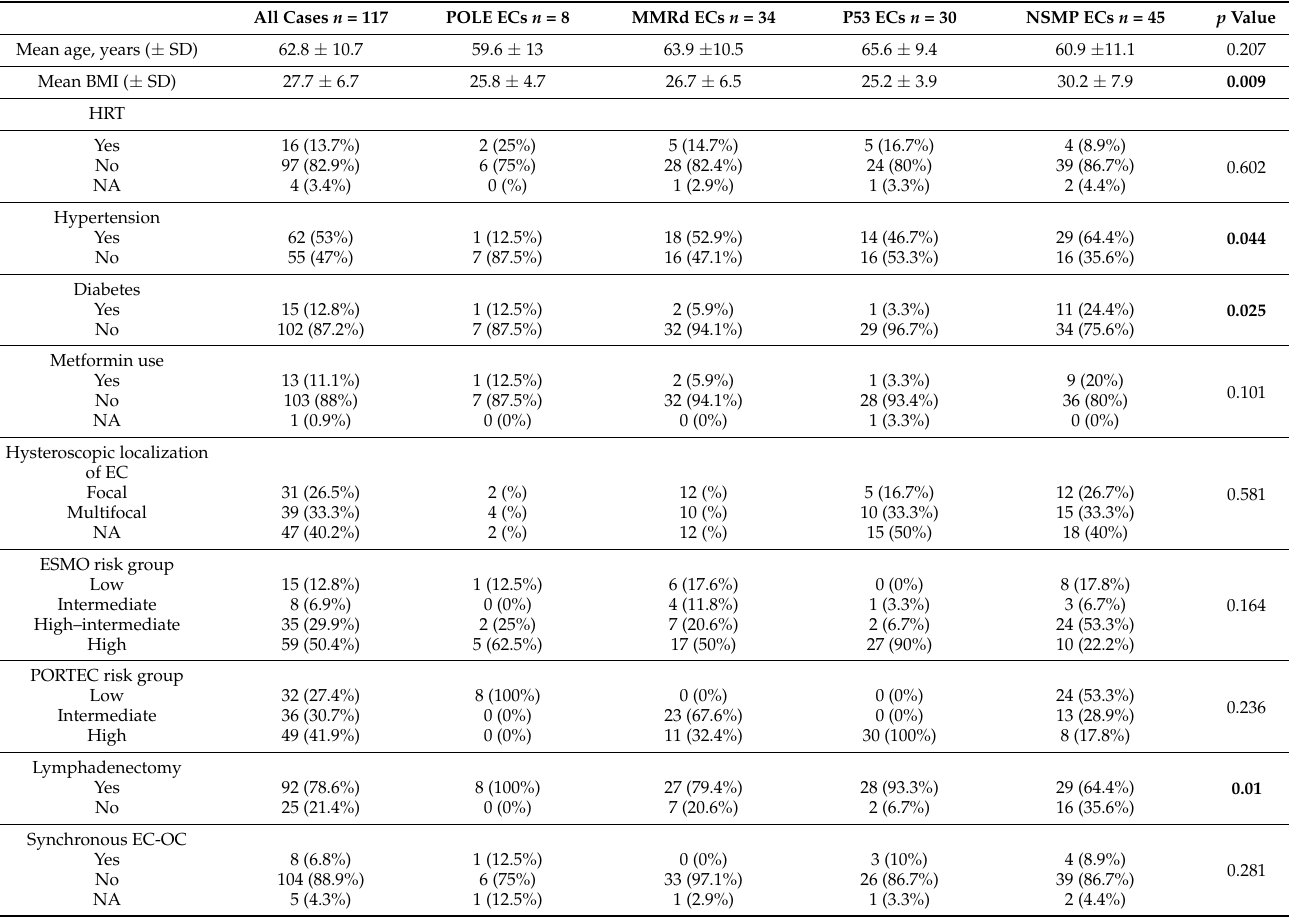
Table 3. Bologna study cohort: patient and surgery characteristics according to TCGA